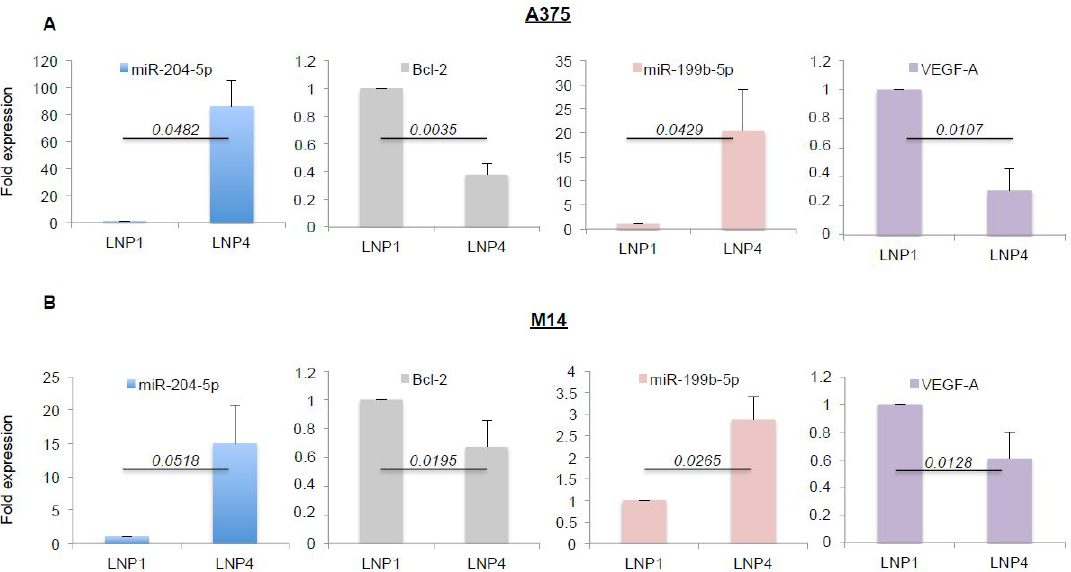
Figure 2. LNP4 upregulates miR-204-5p and miR-199b-5p and inhibits their target genes in human melanoma cells. A375 ( A ) and M14 ( B ) cells were exposed to LNP1 or LNP4, as described above, and then total RNA was extracted to perform qRT-PCR on the expression levels of the indicated miRNAs or their target genes. Results were normalized by ∆∆ CT method relative to U6 and GAPDH,